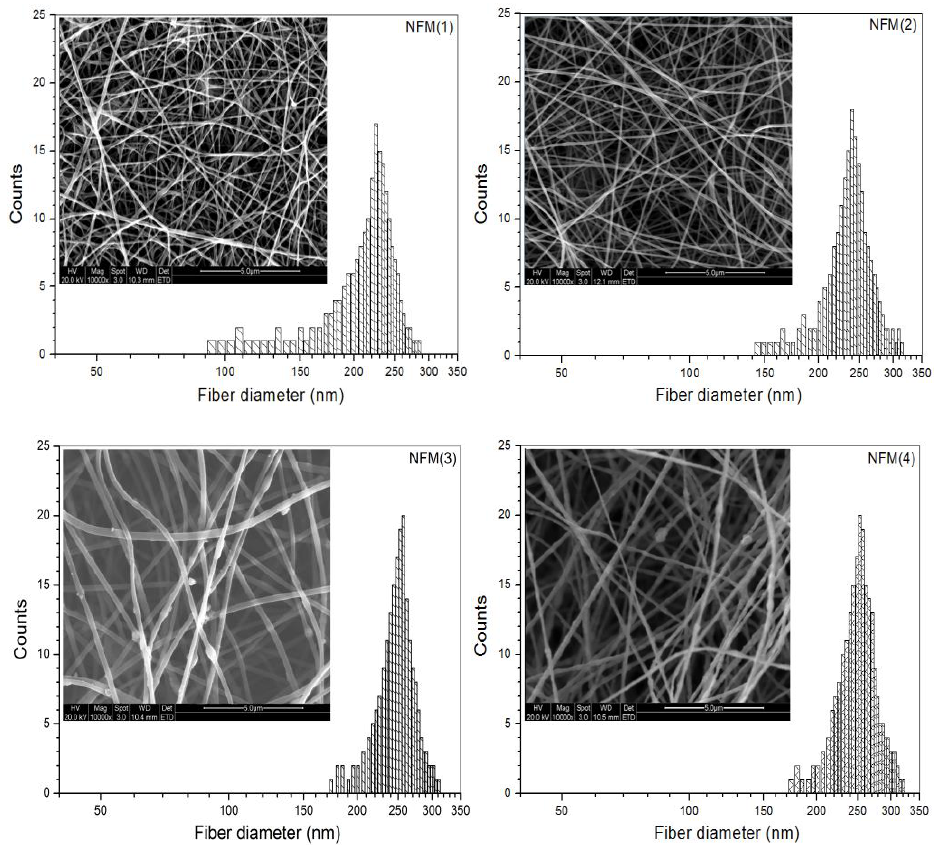
Figure 1. Micrographs of nanofibrous membranes and diameter distributions of nanofibers (see Table 1 for their parameters).